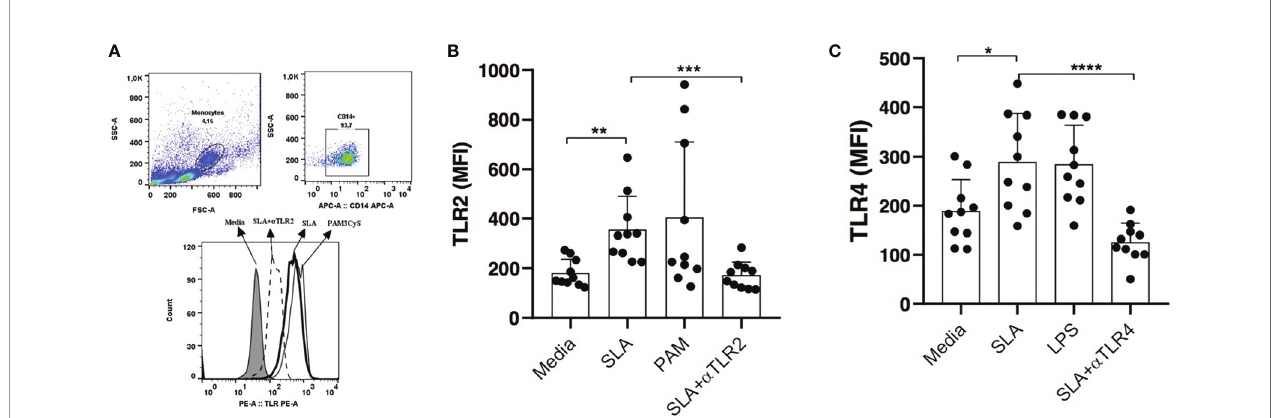
FIGURE 5 | Expression of TLR2 and TLR4 after stimulation with leishmania soluble antigen (SLA). PBMCs from CL patients (n=10) were stimulated with 5ug/ml SLA for 2 hours. Pam3Cys (a TLR2 agonist) and LPS (a TLR4 agonist) were used as positive controls (A) .The expression of TLR2 (B) and TLR4 (C) were quanti fi ed by